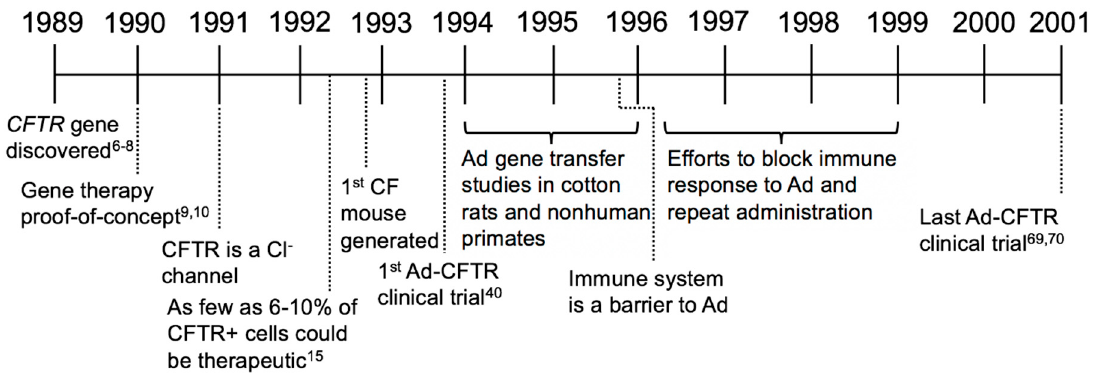
Figure 2. Timelines of CF gene therapy eras: Important milestones impacting the CF field are represented in timelines at the beginning of each era. The timelines are intended to orient the reader to new developments relative to other events and are not comprehensive of all contributions to the field (1989–2001).